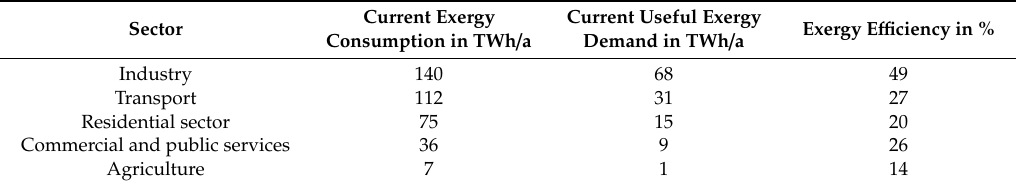
Table 10. Austria-wide comparison of the current exergy consumption and the current useful exergy demand per sector, including the exergetic e ffi ciency. The e ffi ciency is the highest in the industrial sector, since it needs a lot of heat at high temperature levels.